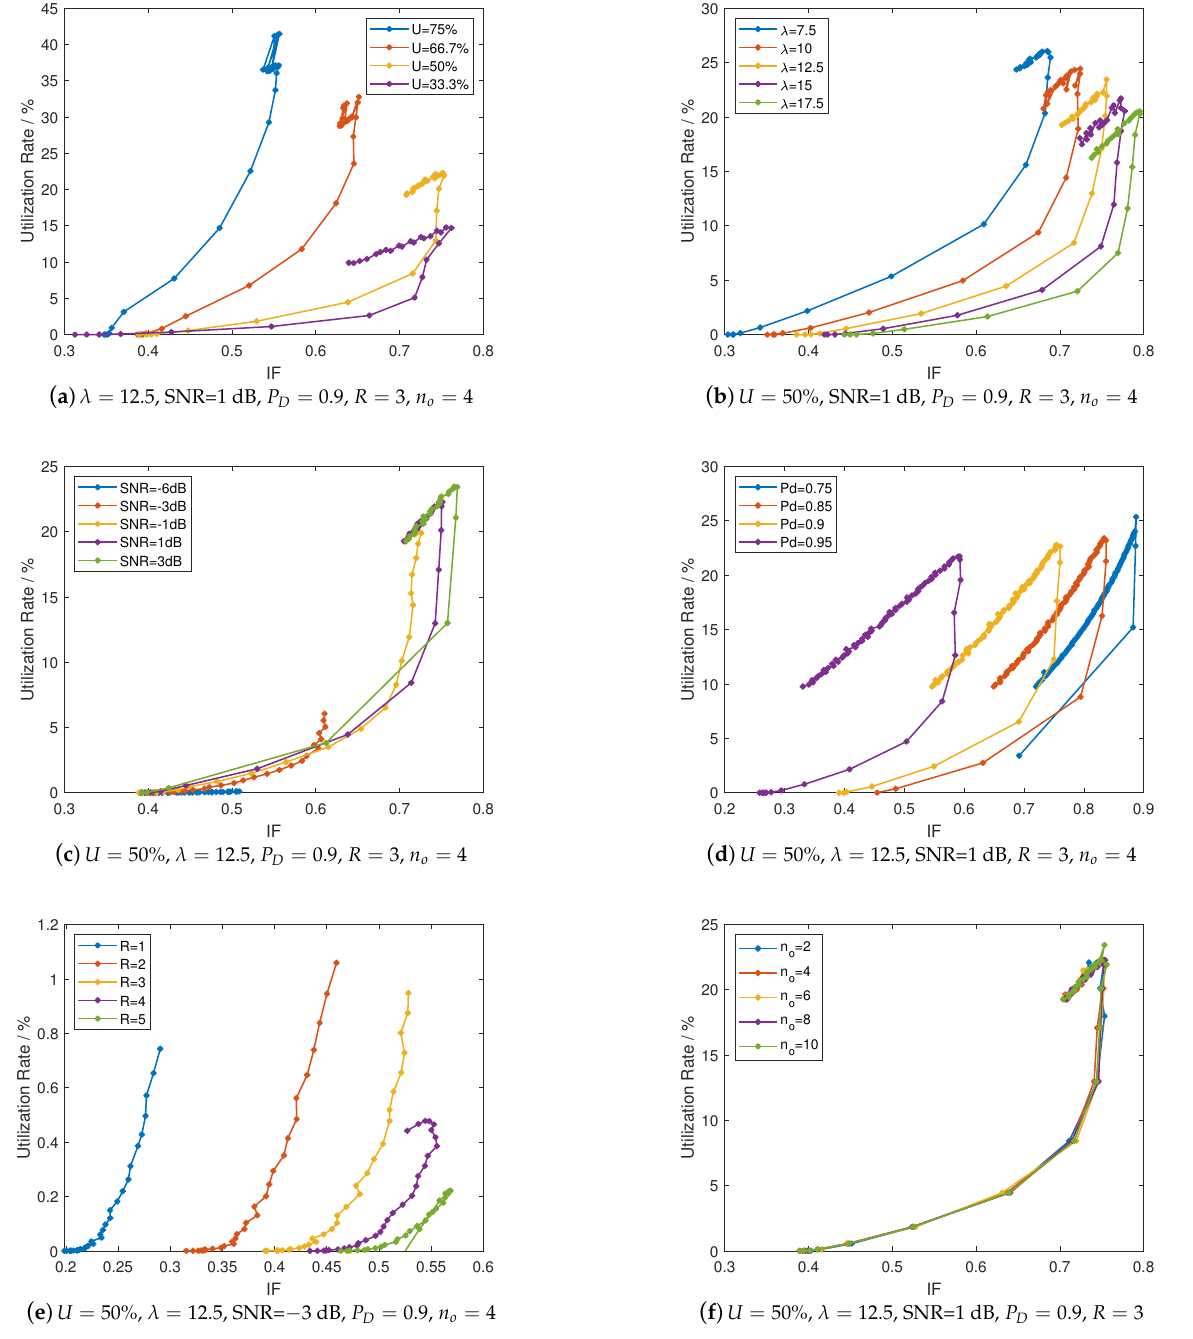
Figure 12. Utilization rate versus interference factor by differing T sen with M = 6 links and K = 3